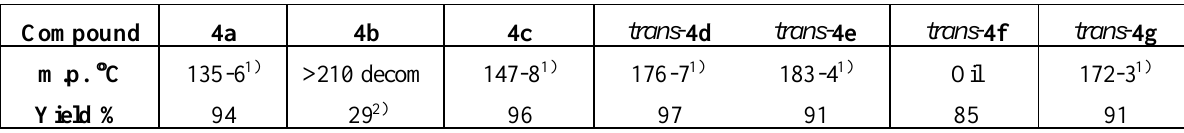
Table 1. Melting Points and Yields of Compounds 4a-g .